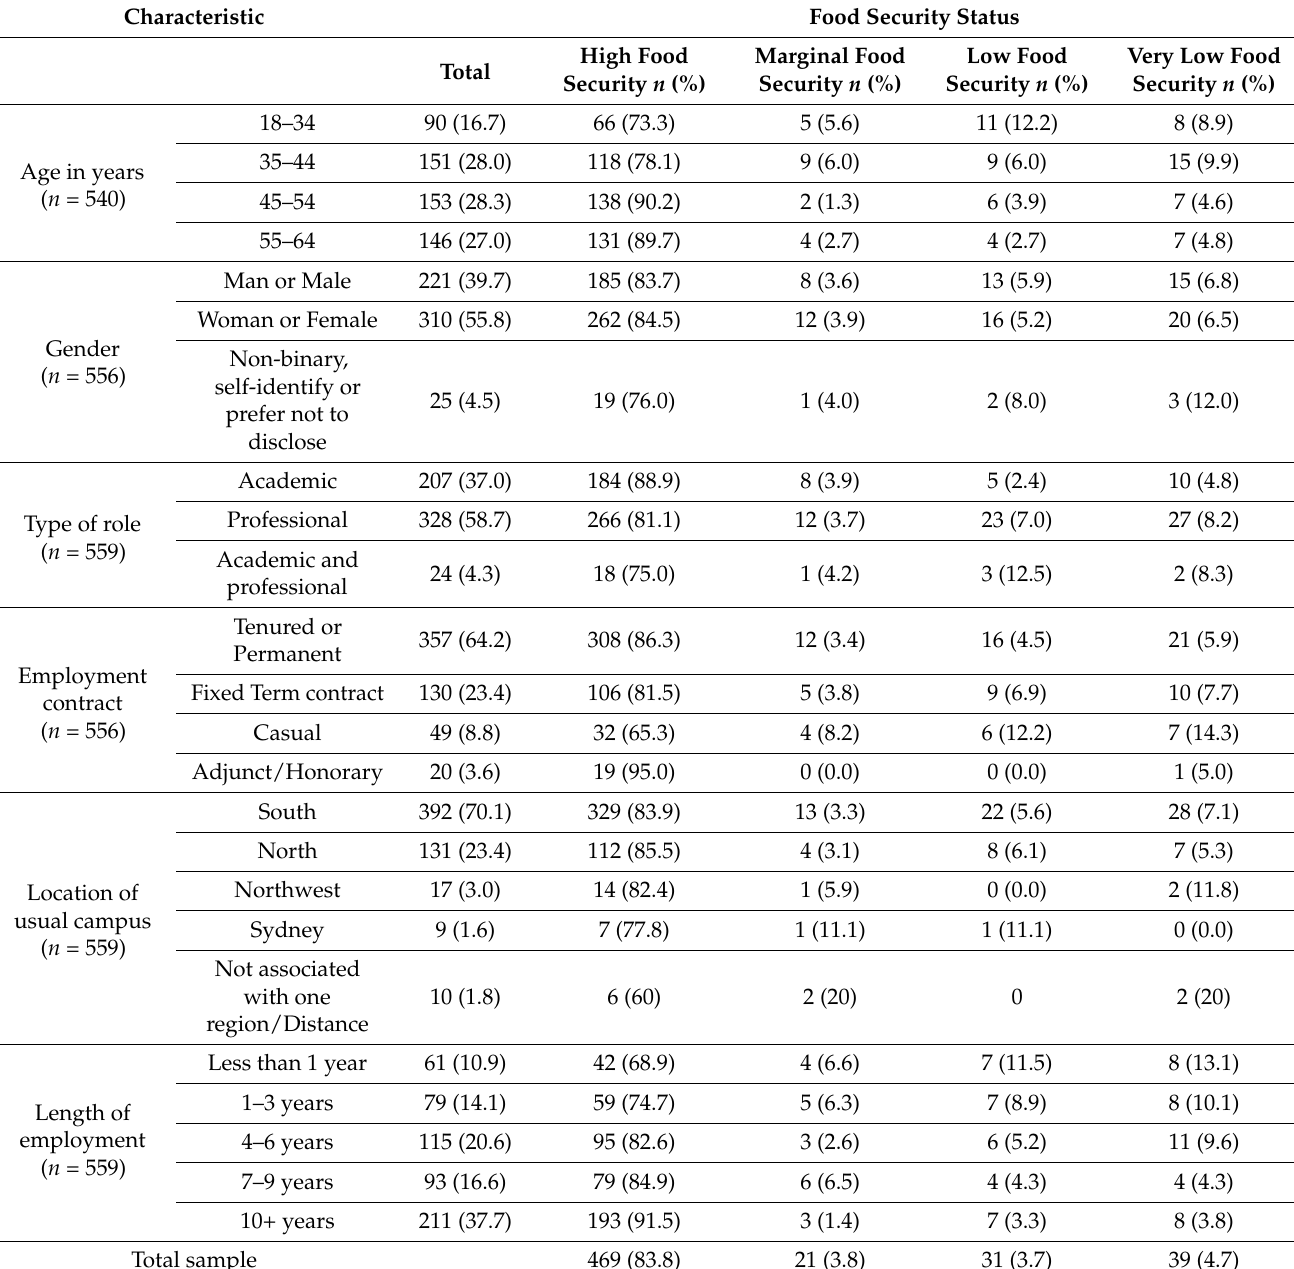
Table 3. Food Security Status of the sample of university staff according to demographic and employment